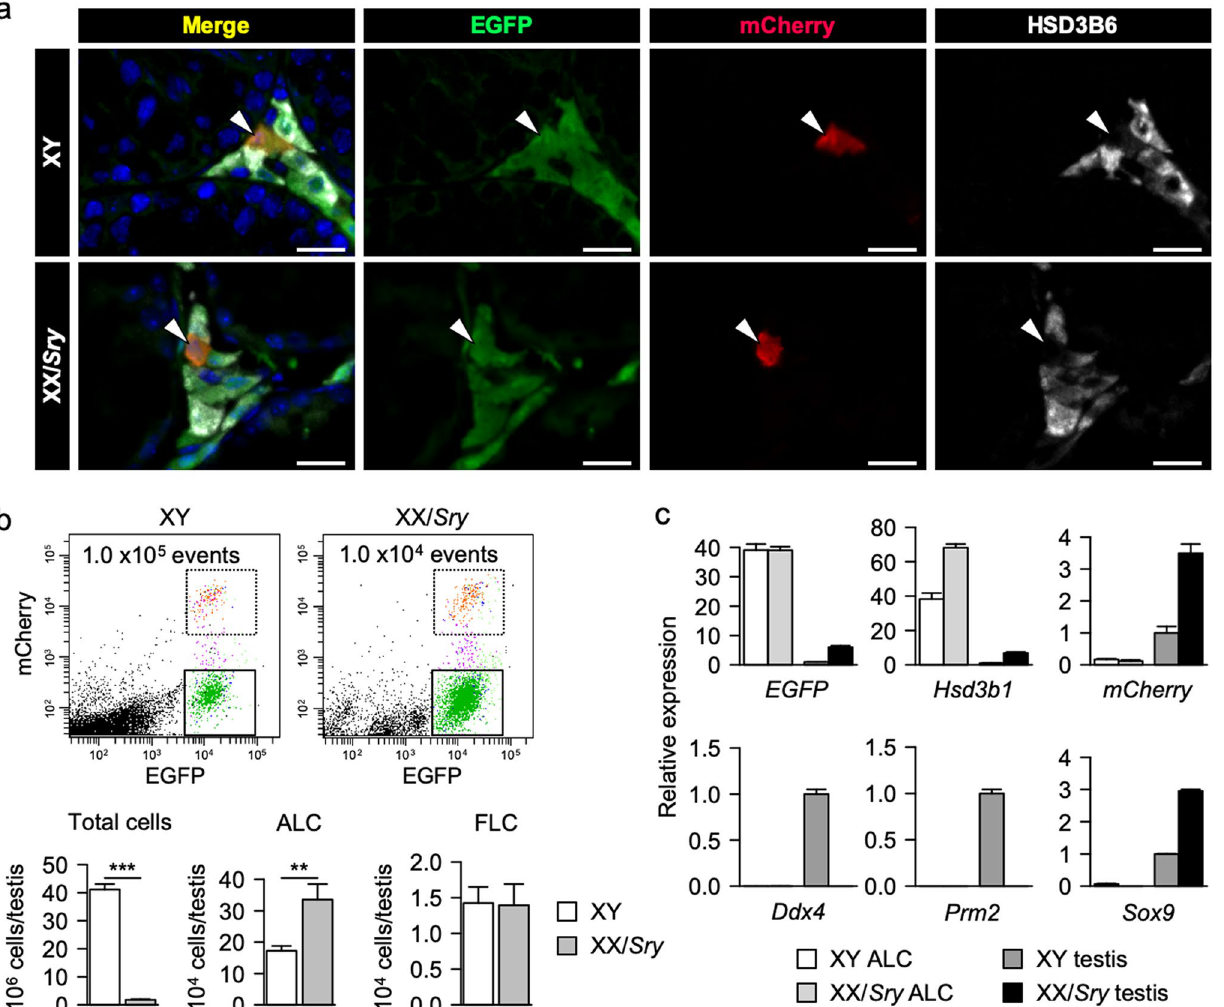
Figure 1. Preparation of ALCs from XY and XX/ Sry testes. ( a ) XY and XX/ Sry testes from eight-week-old Ad4BP-BAC-EGFP/mFLE-mCherry mice were immunostained with antibodies for EGFP (green), mCherry (red), and HSD3B6 (white). Nuclei were stained with DAPI (blue). Merged images are shown on the left. Arrowheads indicate FLCs (EGFP/mCherry double-positive, HSD3B6-negative). ALCs were detected as EGFP/ HSD3B6 double-positive, mCherry-negative cells. Scale bars = 20 μm. ( b ) Whole cell preparations from the testes of 8-week-old XY and XX/ Sry mice were analyzed via FACS. The cells surrounded by solid lines were recovered as EGFP single-positive ALCs, whereas those surrounded by dotted lines were recovered as EGFP/ mCherry double-positive FLCs (upper panels). Total testicular cells were counted. Numbers of ALCs and FLCs per testis are calculated using the results obtained by FACS. Nine biologically independent samples (n = 9) were used for counting (lower panels). ( c ) The expression levels of marker genes in the sorted XY and XX/ Sry ALCs, along with those of EGFP and mCherry, were examined using qRT-PCR. XY and XX/ Sry testes were used as controls. Three biologically independent samples (n = 3) were used. The data were normalized to Actb and are presented as means ± SEM. * p < 0.05, ** p < 0.01, *** p < 0.001, using Student’s t -test ( b ). R software version 3.4.3 (https ://www.r-proje ct.org) was used to draw the plots in ( b , c